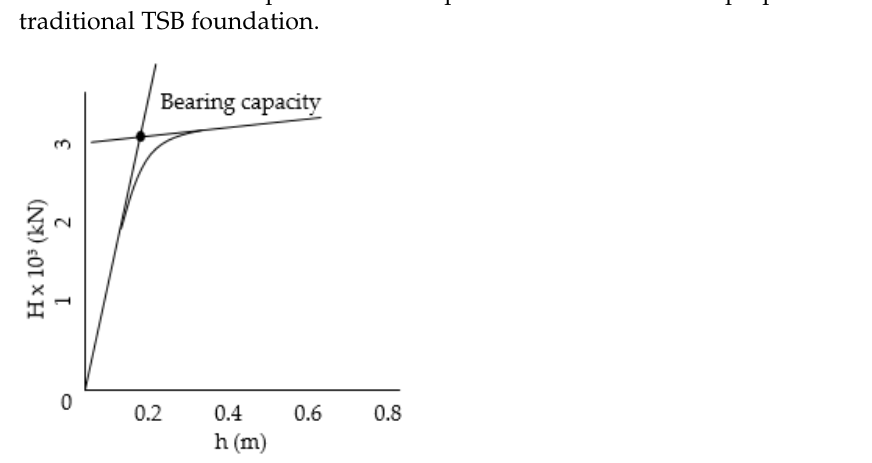
Figure 5. Tangent intersection method for determining bearing capacity [31].